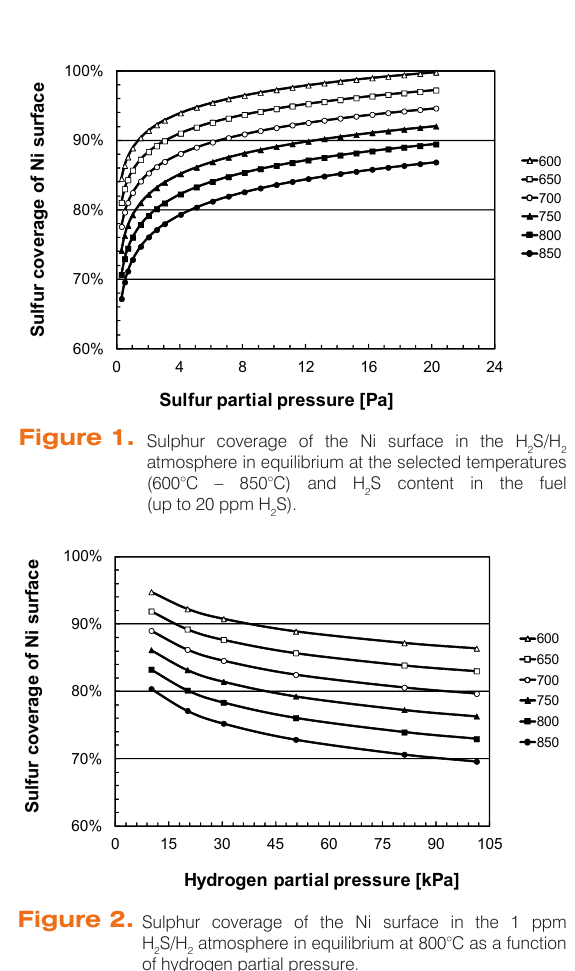
Sulphur coverage of the Ni surface in the 1 ppm